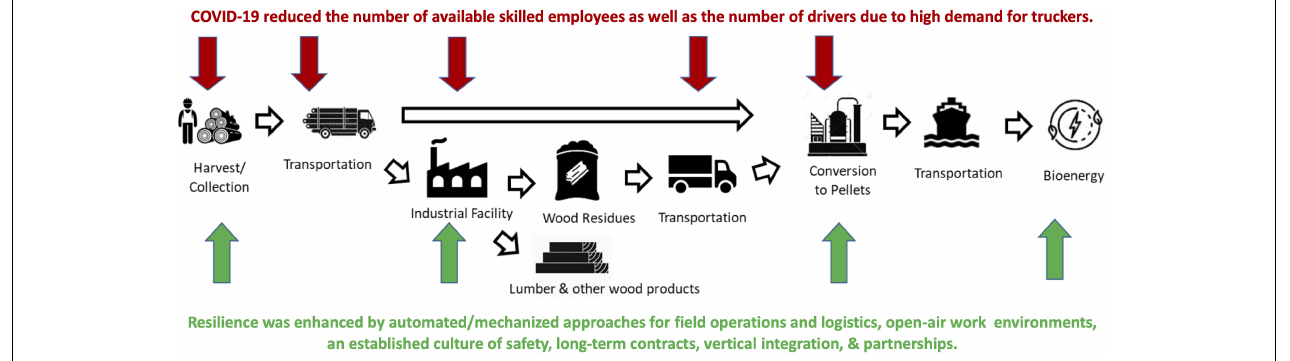
FIGURE 5 | Supply chain for wood-based pellets from the SE United States shipped overseas for bioenergy illustrating steps where COVID-19 had impacts (solid red arrows) and examples of mitigating conditions that supported resilience (green arrows) [modified from Kline et al.